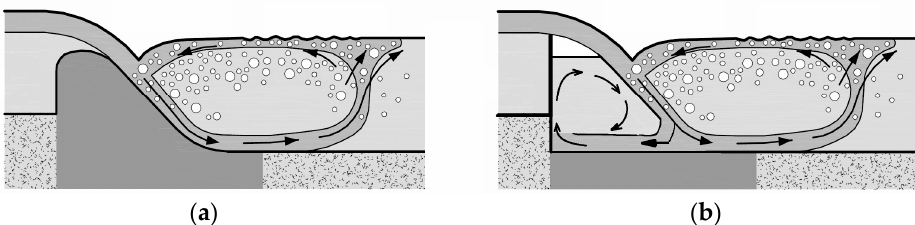
Figure 5. Differences between ( a ) ogee crest and ( b ) sharp crested weirs. The forward rotating eddy between the sharp-crested weir plate and the overflowing nappe introduces additional energy loss that does not occur with an ogee crest.